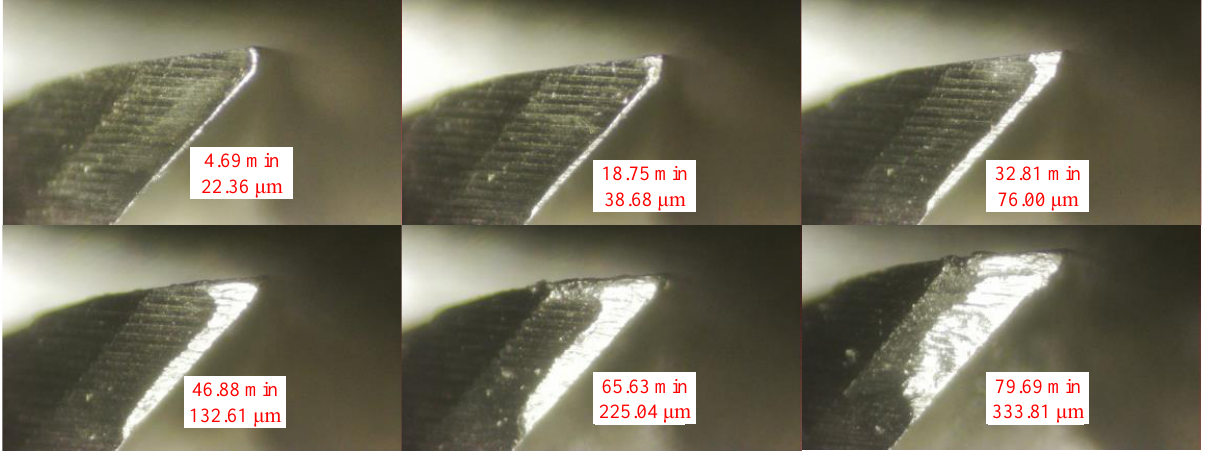
Figure 17. Partial tool wear detection photos.